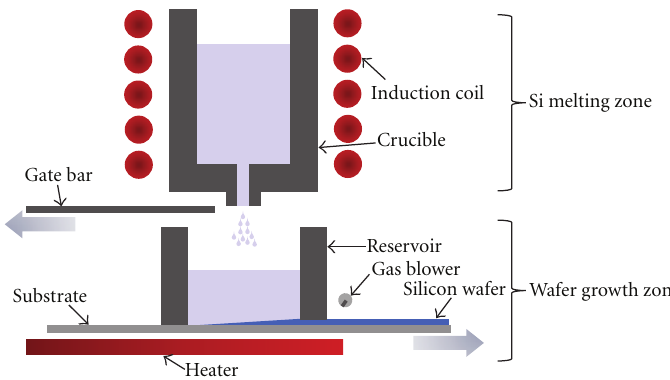
Figure 1: Schematic diagram of a horizontal growth system for ribbon-typed Si